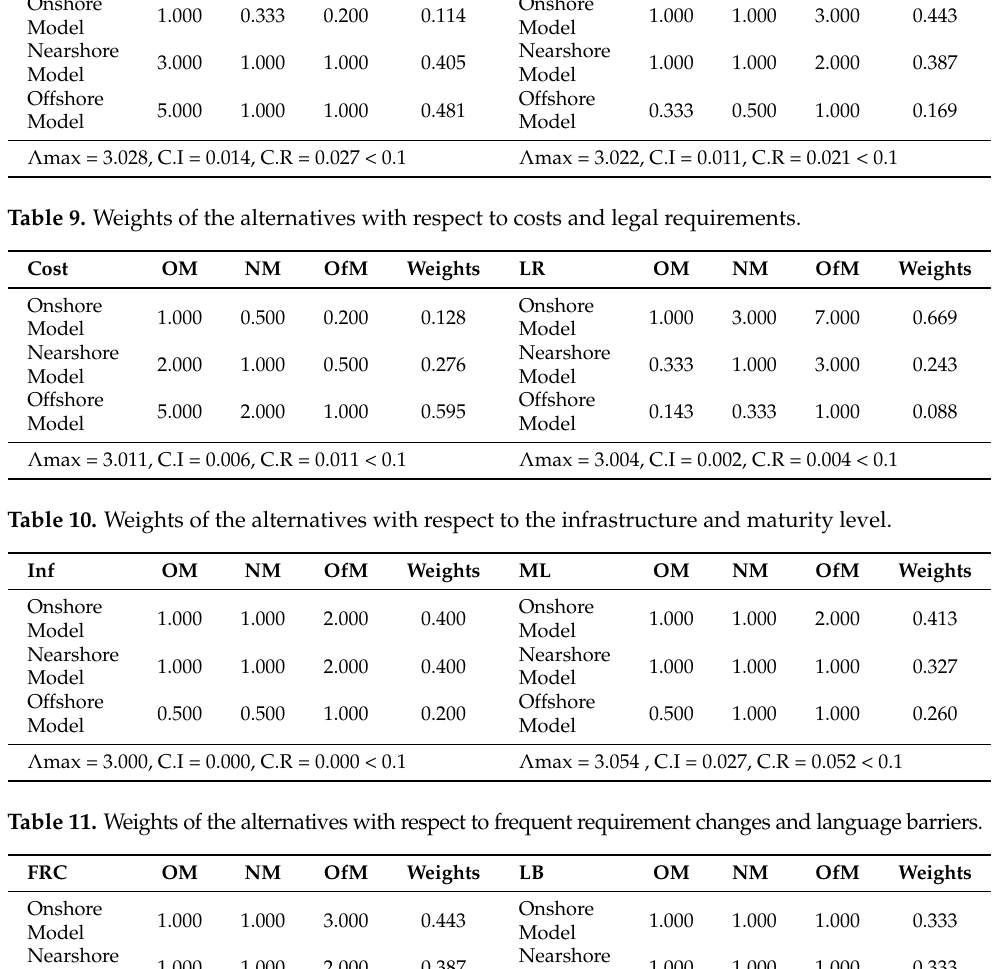
Table 8. Weights of the alternatives with respect to employee skills and poor communication. ES